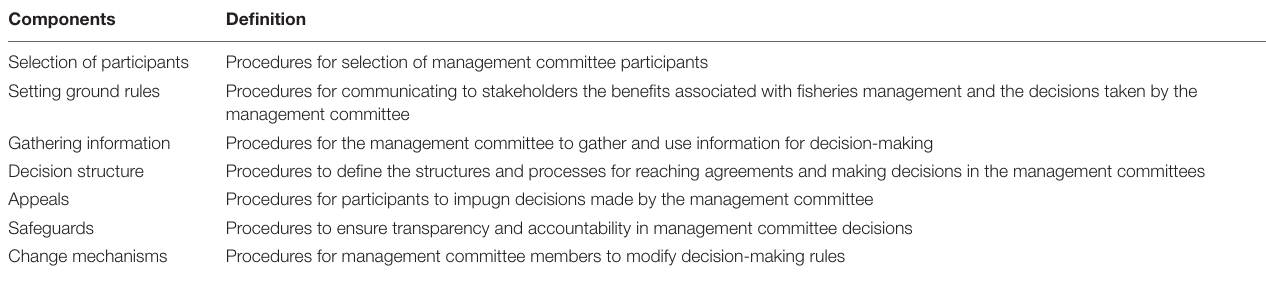
TABLE 1 | Definition of the components used to assess the achievement of procedural justice in management committees (based on Leventhal, 1980).